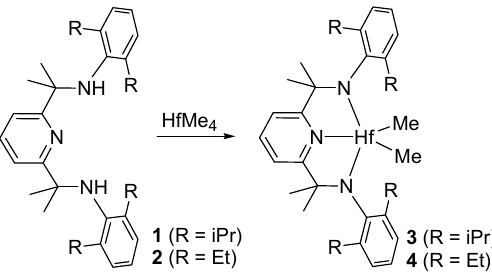
Scheme 1. Synthesis of pincer-type [N amido , N pyridine , N amido ]HfMe 2 complexes.